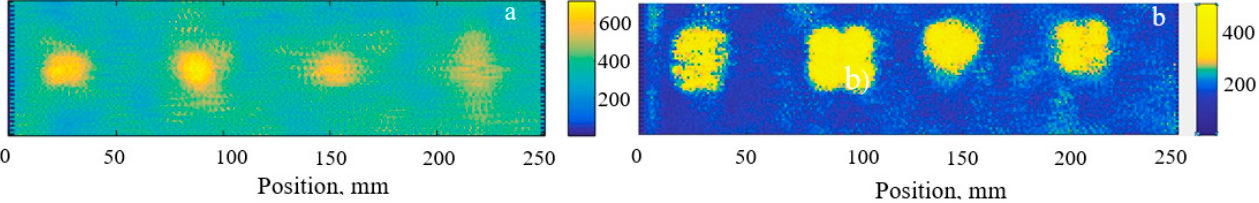
Figure 8. Multiple-defect imaging in noisy mode of RACE: 4 circular FBH of different depths ( a ) and 4 square inserts at various depths ( b ) in CFRP plate.